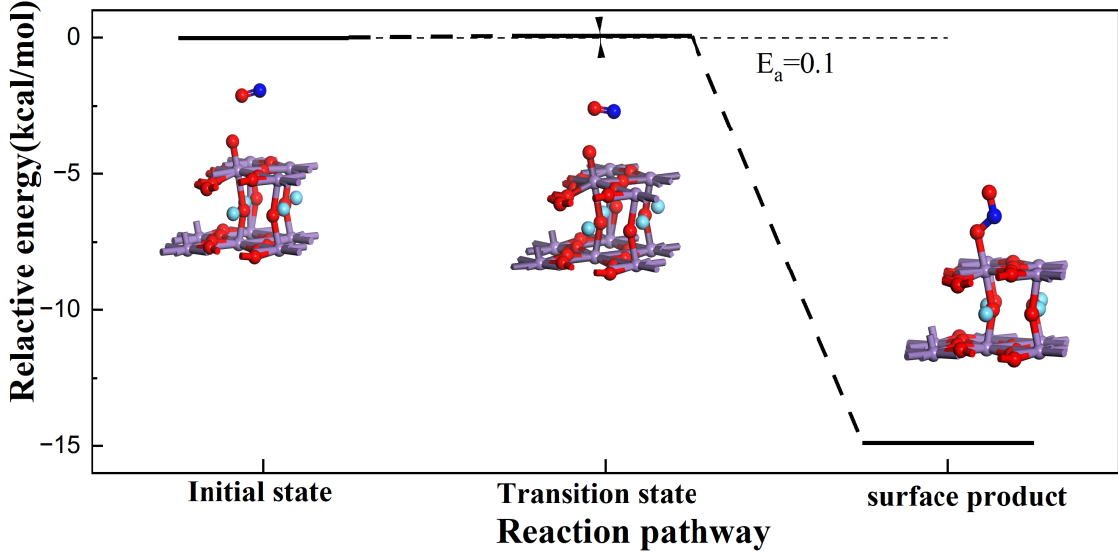
Figure 11. The formation process of NO 2.